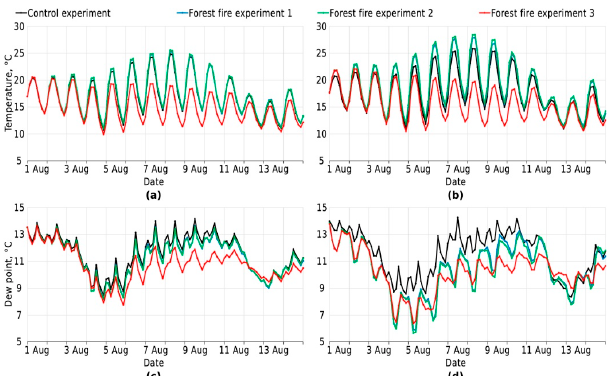
Figure 2. Temporal variability of air temperature and dew point for Area 1 from 1–14 August 2019 under various forest fire experiments: ( a ) mean air temperature (2 m height) for the entire area, °C; ( b ) mean air temperature at the burned sites, °C; ( c ) mean dew point (2 m height) for the entire area, °C; ( d ) mean dew point at burned sites, °C.